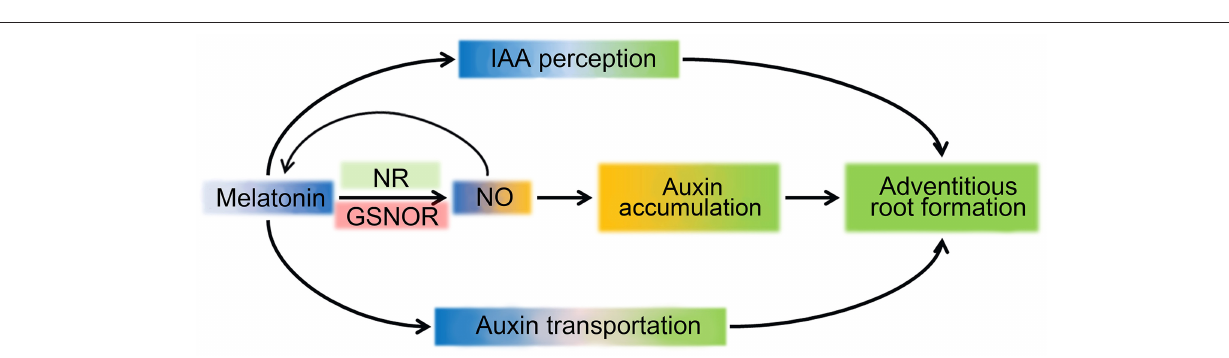
Frontiers in Plant Science |